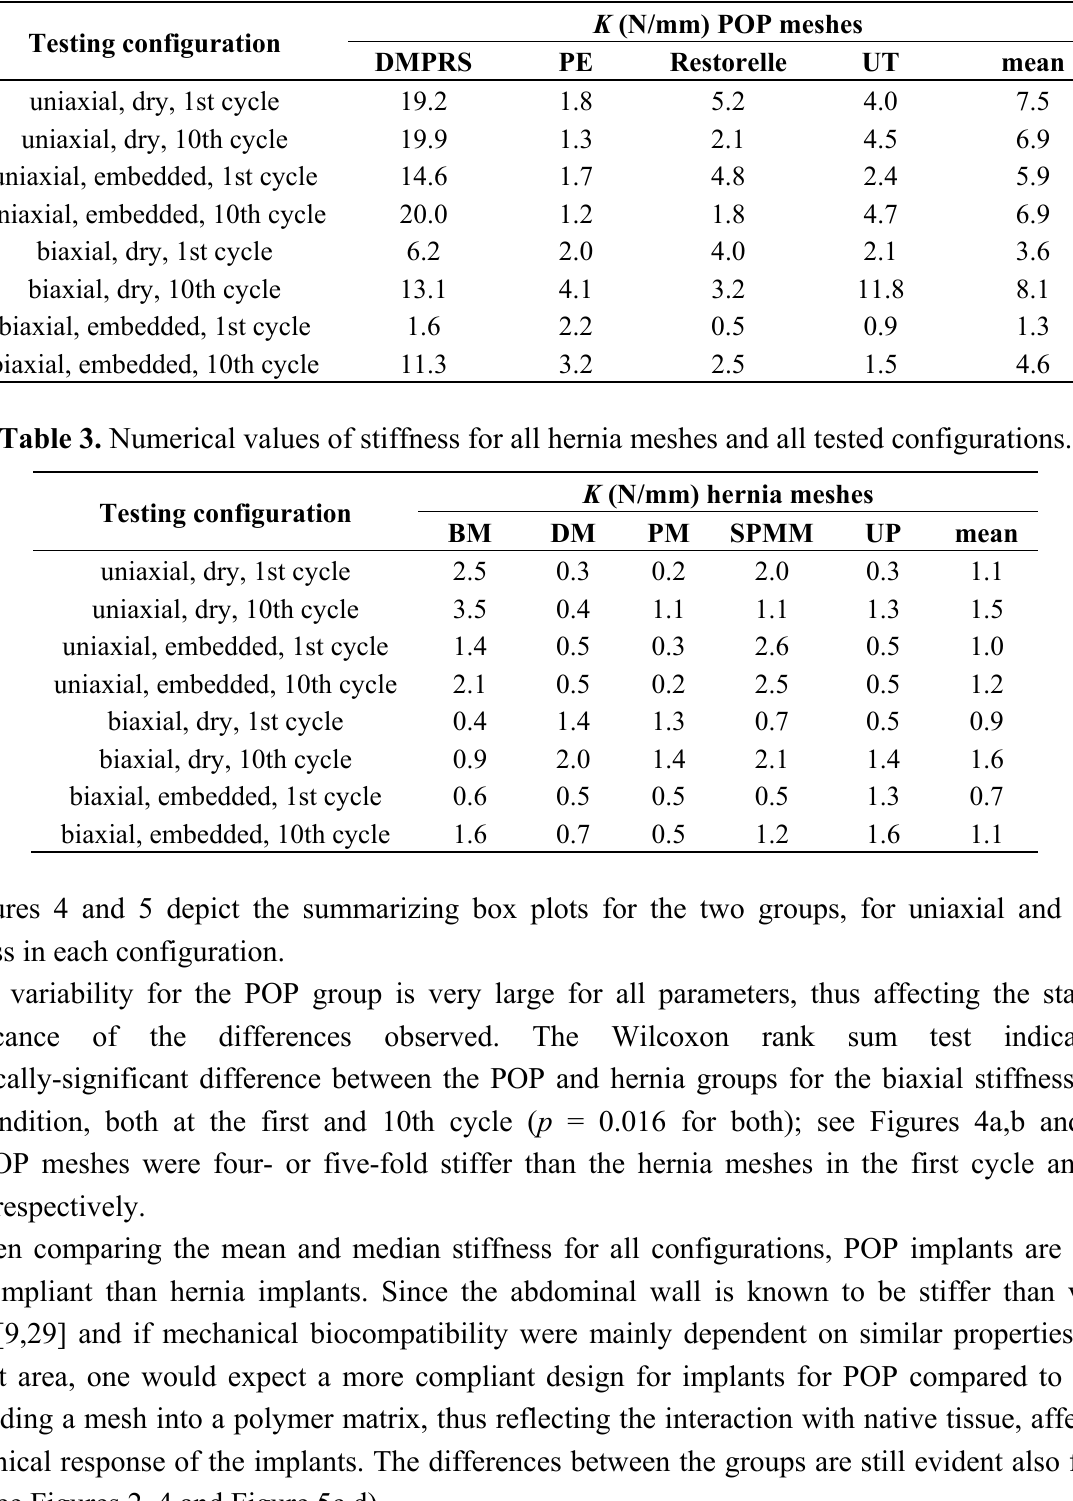
Table 2. Numerical values of stiffness for all POP meshes and all tested configurations.